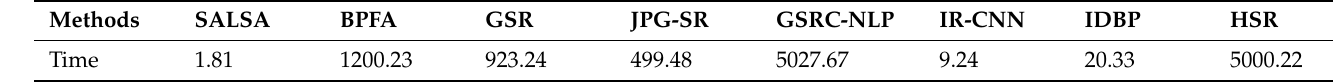
Table 9. Comparison of running time in seconds of different